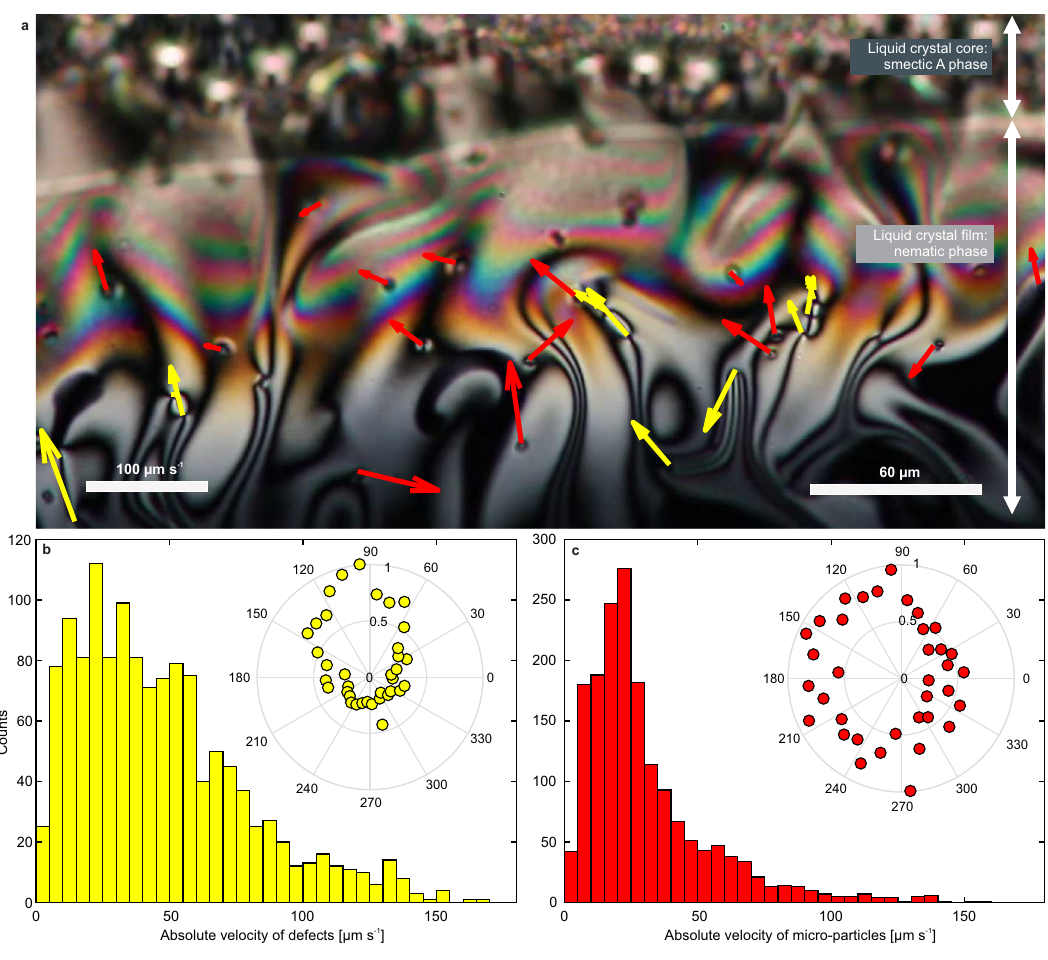
Fig. 5 | Velocity analysis of defect and tracer movement in a typical 25 s video. a A frame from the analyzed video. Yellow arrows present the tracked defects' velocitiesandredarrowsthetrackedvelocitiesoftracerparticles. b Distributionof absolutevelocitiesofdefects.Angulardistributionofmeasureddefectmovements